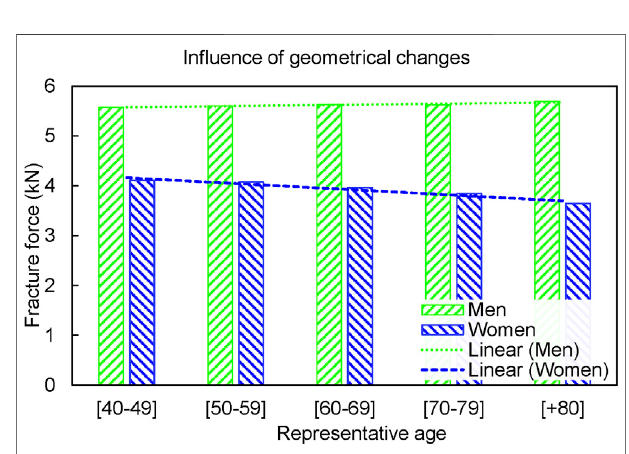
FIGURE 3 | The fracture forces in GeomAge set slightly increased (25 N per decade) for men, and it reduced by 116 N per decade for women.